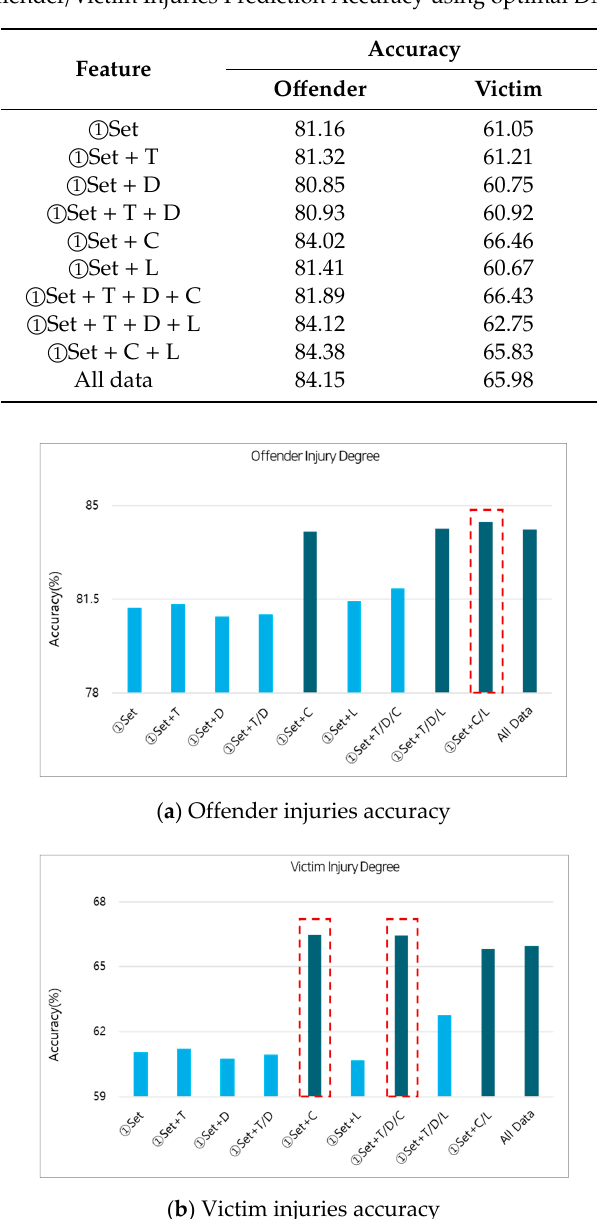
Table 7. O ff ender / Victim Injuries Prediction Accuracy using optimal DNNs model.